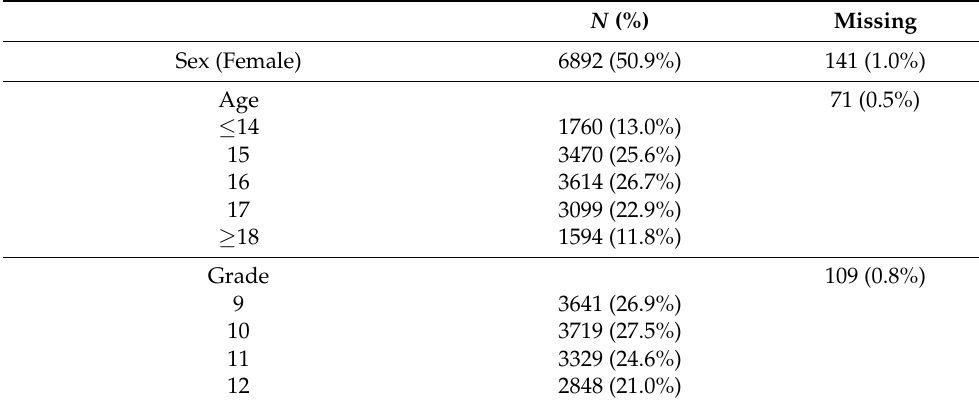
Table 1. Descriptive statistics for sample demographic characteristics, physical activity, sleep, and aca- demic